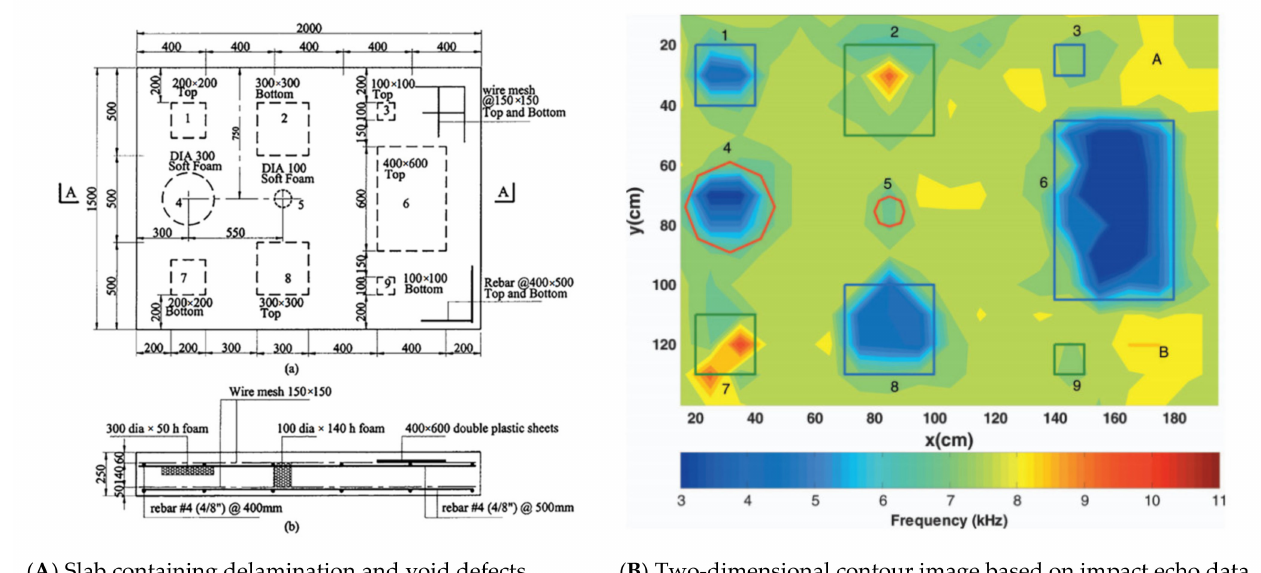
Figure 5. ( A ) Slab containing delamination and void defects. ( a ) Plan view; ( b ) Cross Section A-A; ( B ) Two-dimensional contour images of Slab built up using air-coupled impact-echo data. The solid lines indicate the location of defects